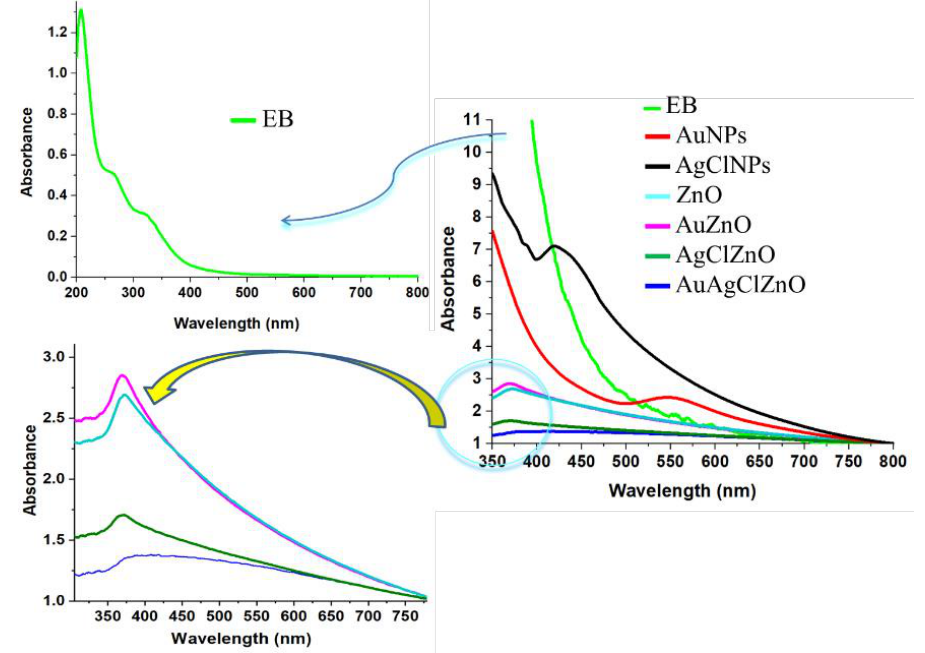
Figure 1. Comparative presentation of UV-Vis absorption spectra of burdock-derived samples. All spectra were normalized at 800 nm. The bottom inset shows the spectral fingerprint of ZnO particles. The top inset shows the spectrum of burdock extract (EB).